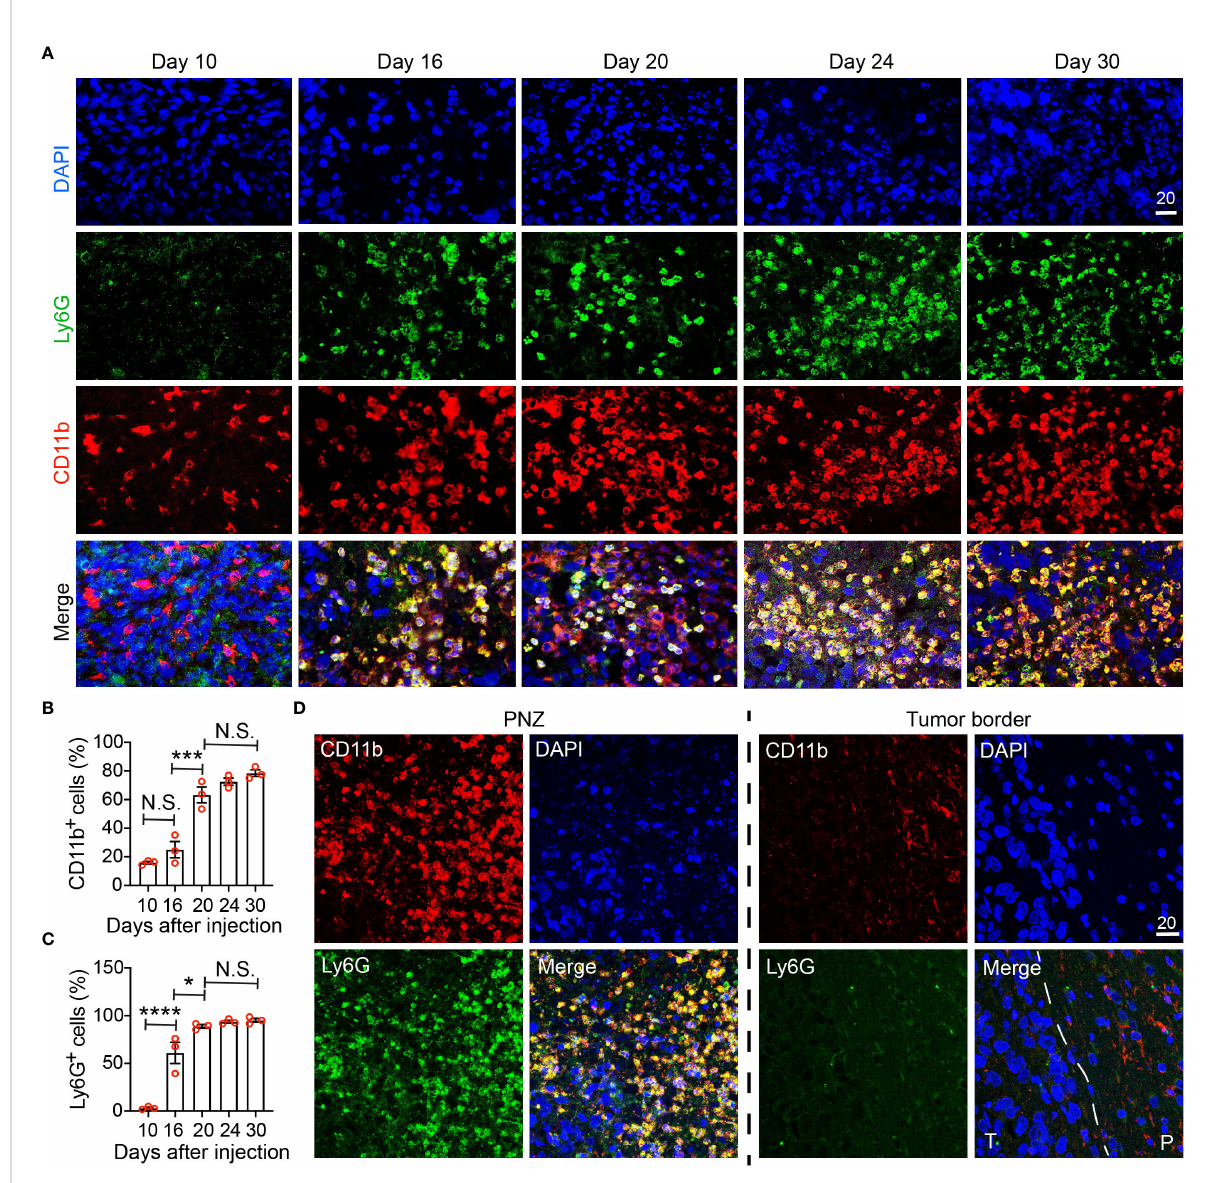
FIGURE 6 Immunohistochemical characterization of the temporal development of GBM tumor necrosis. (A) Temporal development of GBM tumor necrosis from the early to the late tumor progression using representative time-course CD11b, Ly6G, and DAPI immuno fl uorescence staining on brain sections collected from LN229 TAZ(4SA) brain tumor-bearing mice. (same cohort of animals as in Figure 5). For day 10, an area of cellular tumor was imaged. For day 16-30, an area of peri-necrotic zone at the interface between cellular and necrotic tumor was imaged for each sample. Images in each column were acquired from the same animal. (B) Percentage of CD11b + cells normalized to all DAPI + cells in one high- power 40X fi eld collected at each timepoint indicated in panel (A) . p ANOVA <0.0001. Results of post hoc test for each continuous time point are indicated. (C) Percentage of Ly6G + cells normalized to all CD11b + cells in one high-power 40X fi eld collected at each timepoint indicated in panel (A) . p ANOVA <0.0001. Results of post hoc test for each continuous time point are indicated. Each datapoint shown in the bar graphs represents an animal. Ordinary one-way ANOVA. Sidak ’ s multiple comparisons test was used in the post hoc test. All center values shown are mean values, and all error bars represent standard errors of the means (s.e.m). N.S., p > 0.05. *,p < 0.05; ***,p < 0.001; ****,p < 0.0001. (D) Comparison of immuno fl uorescent images as above acquired from a terminal-stage (i.e., day 30) section between the peri-necrotic zone, denoted by PNZ, and from the tumor border; dashed line outlines the tumor (T) and normal parenchyma (P) border. Tumors from three tumor- bearing mice were sectioned and imaged in parallel as replicates with consistent observations (n=3). Scale bar is in